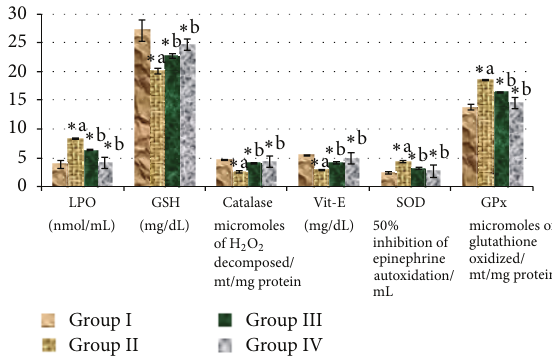
Figure 5: Effect of ethanolic extract of Triticum aestivum on the antioxidant levels of liver homogenates in STZ-induced model. Values are the mean ± SD for six animals in each group. Values are statistically significant at ∗ P < 0.05; statistical significance was compared within the groups as follows. a Diabetic rats were compared with normal rats. b Glibenclamide and Triticum aestivum treated diabetic rats were compared with diabetic